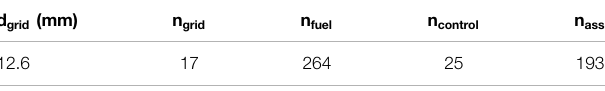
TABLE 2 | Parameters of assemblages in the